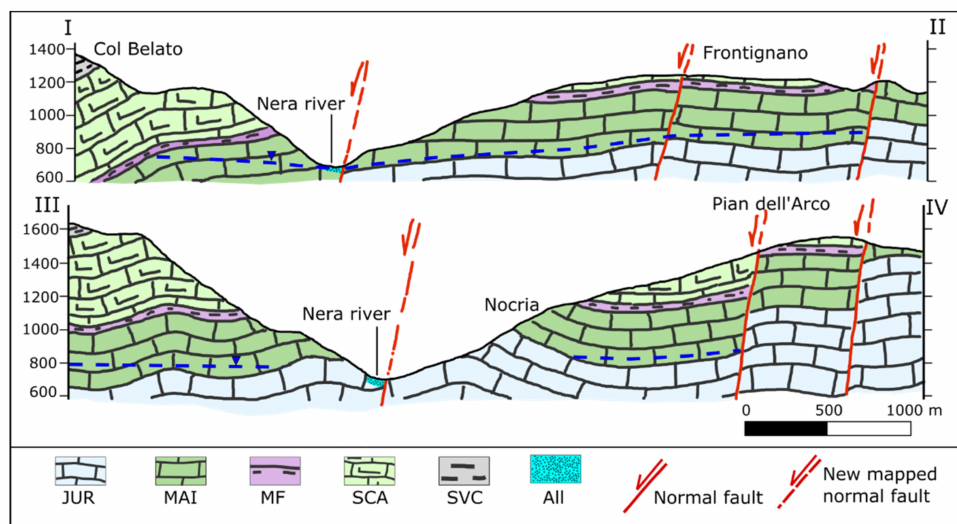
Figure 4. Hydrogeological cross sections with the identification of the new mapped fault and the hypothetic elevation (m a.s.l.) of water table. JUR (Jurassic aquiclude complex), MAI (Maiolica aquifer complex), MF (Marne a Fucoidi aquiclude complex), SCA (Scaglia Calcarea aquifer complex),